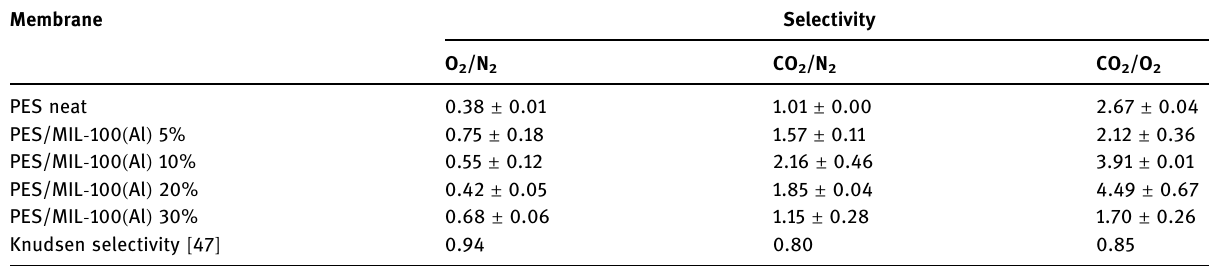
Table 5: The selectivity of the PES/MIL - 100 ( Al ) MMMs